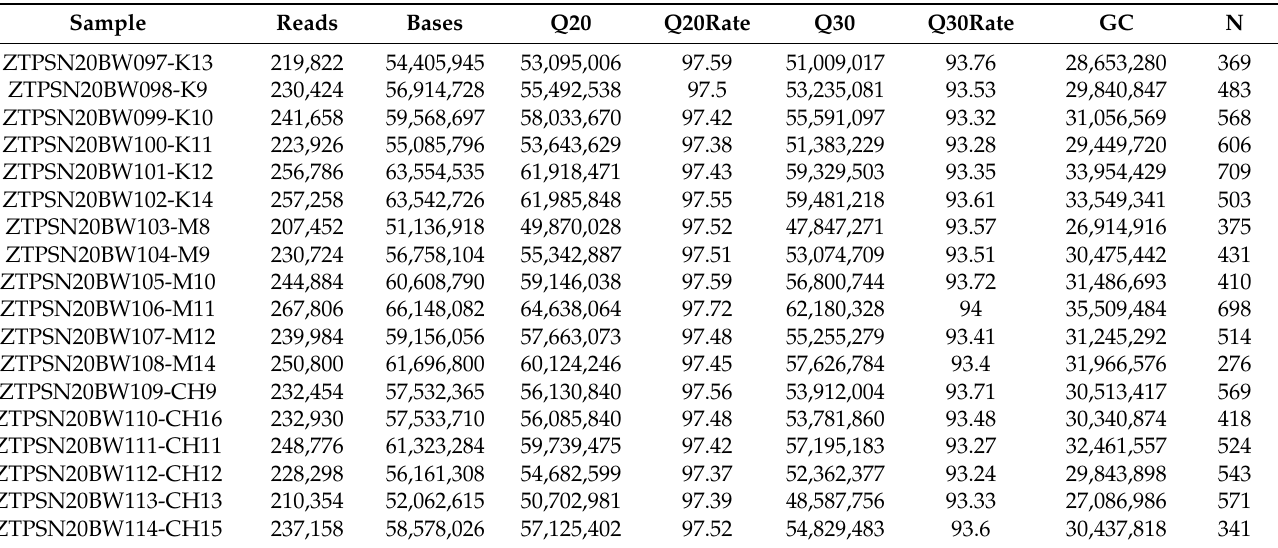
Table 1. The quality control results of the samples.